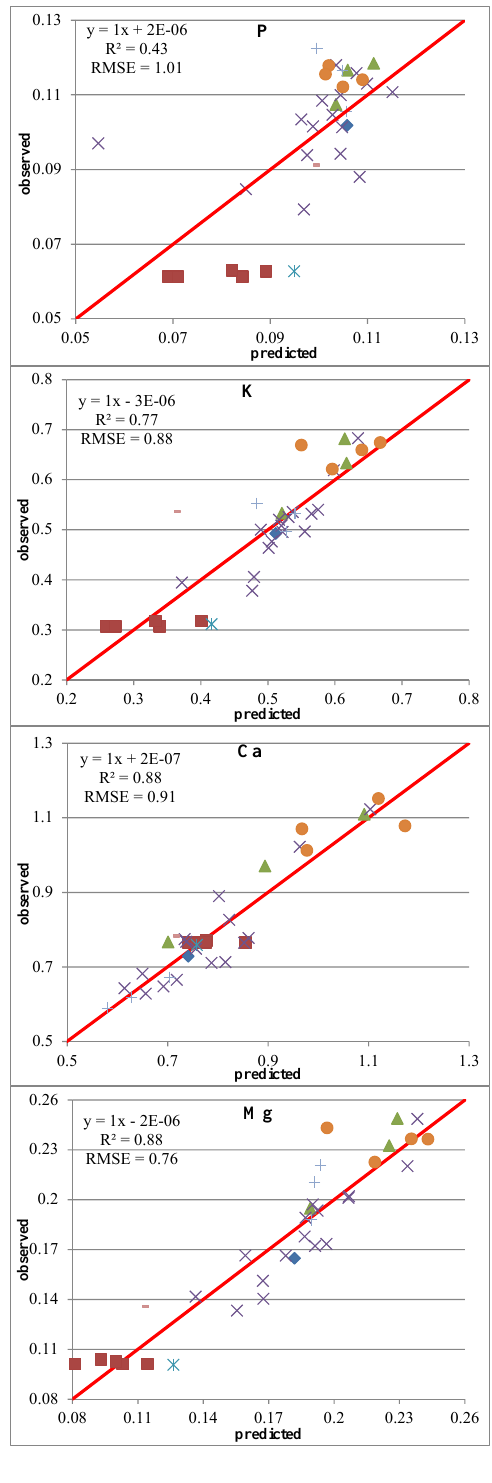
Figure 6. Scatterplots of observed vs. predicted macronutrient concentrations. Left column shows partial least squares (PLS) model fits using only IS data and right column shows PLS model fits using IS and LiDAR data together of N, P, K, Ca and Mg, respectively. Concentration units are %. RMSEs are leave-one-out cross validation errors of standardized data. Red line indicates the 1:1 relationship. Fb = balsam fir; Sb = black spruce; Po = trembling aspen; Bw = white birch; Cw = white cedar; mix1 = mixed deciduous; mix2 = mixed deciduous and conifer; and mix3 = mixed